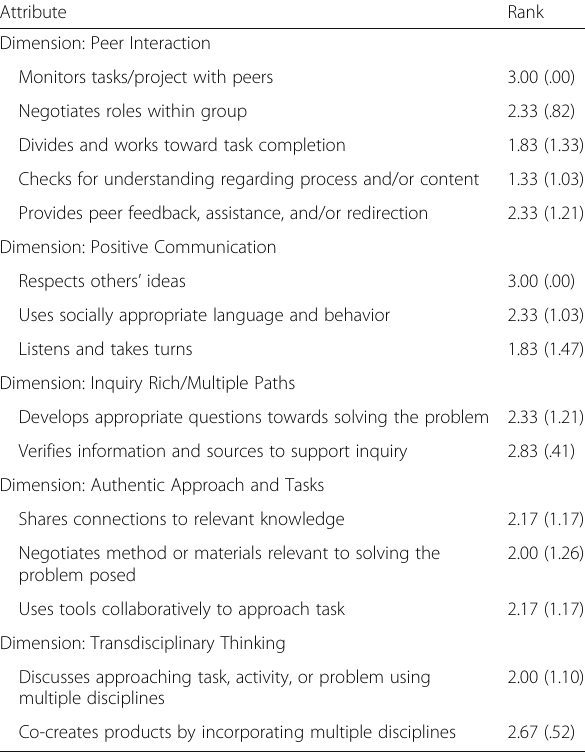
Table 2 Rater agreement of attribute alignment with Rank